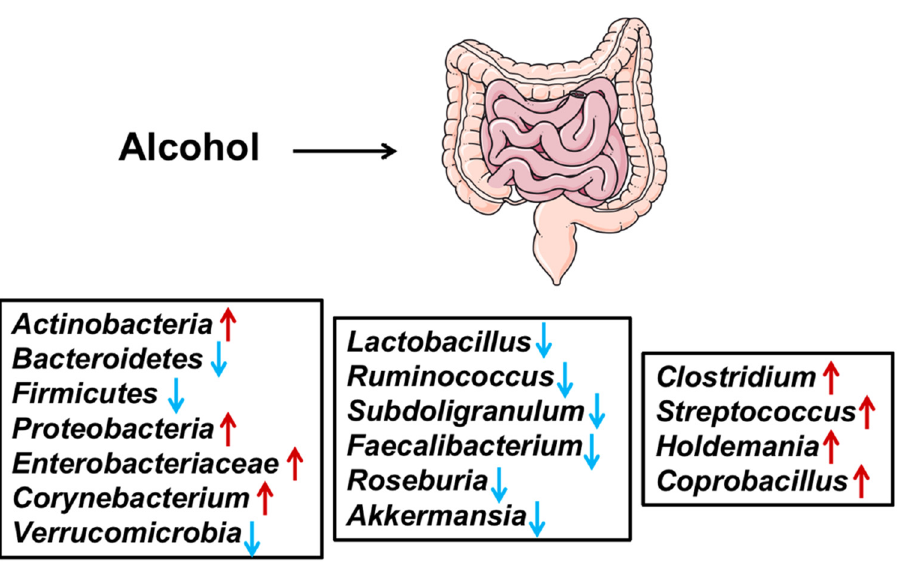
Figure 1. Alcohol abuse significantly affects many microbes in the gut. ↑ , the abundance was upregulated; ↓ , the abundance was down-regulated.